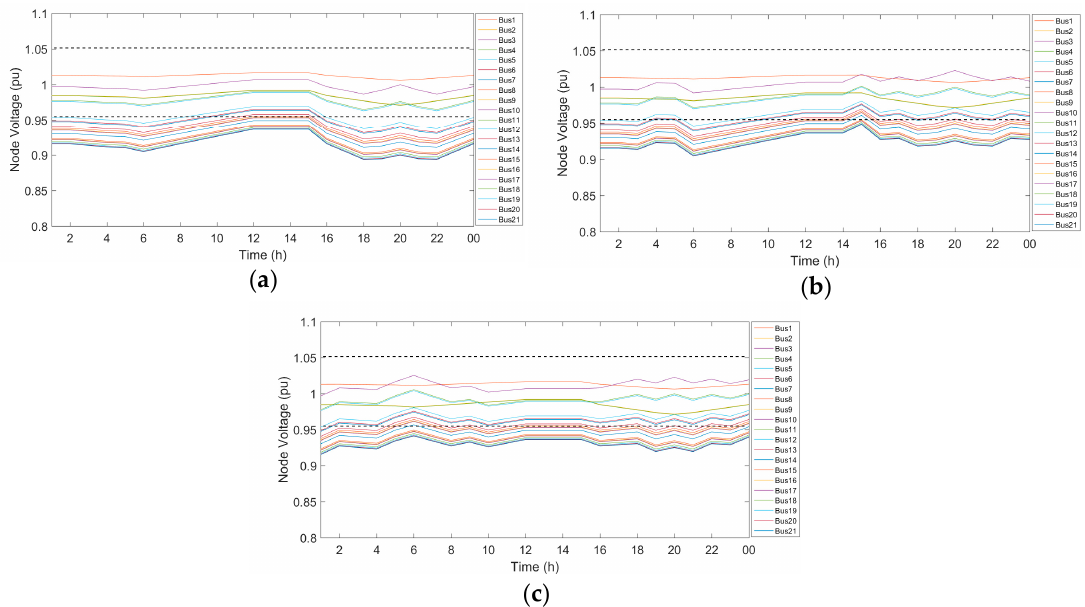
Figure 5. Node voltages of solution A for all tap position constraints ( g A – g C ). ( a ) Node voltages (equality constraint of g A ); ( b ) node voltages (equality constraint of g B ); ( c ) node voltages (equality constraint of g C